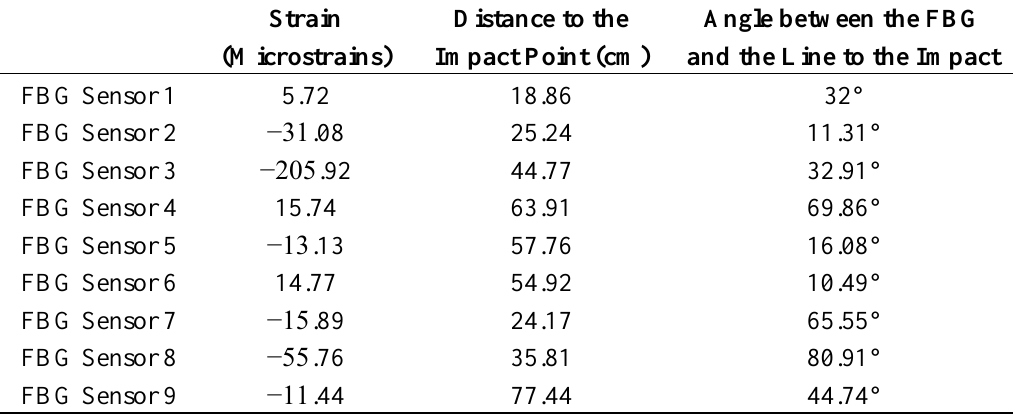
Table 3. Residual strain for the mass of 2.5 kg when it is on the Impact Point 1 after the impact.